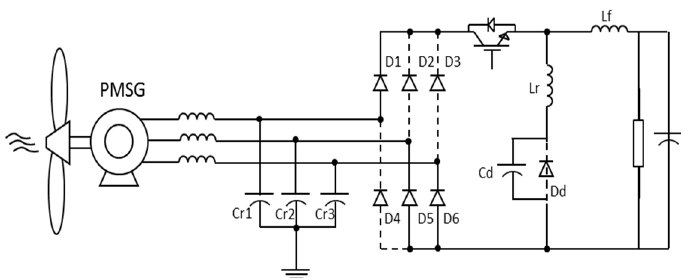
Figure 12. Equivalent circuit: Step